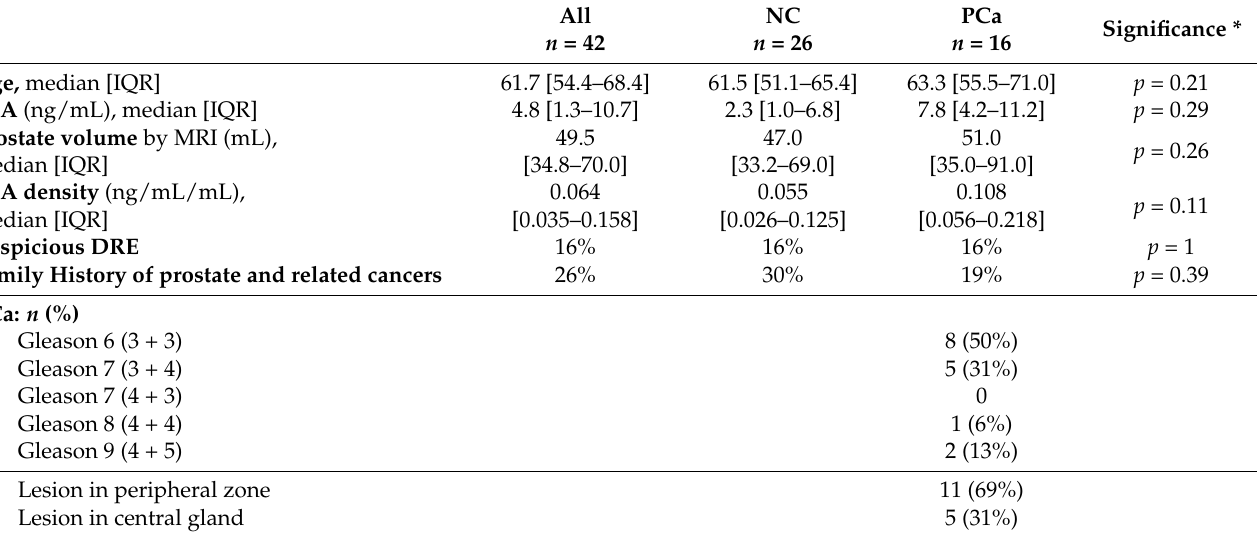
Table 1. Patient